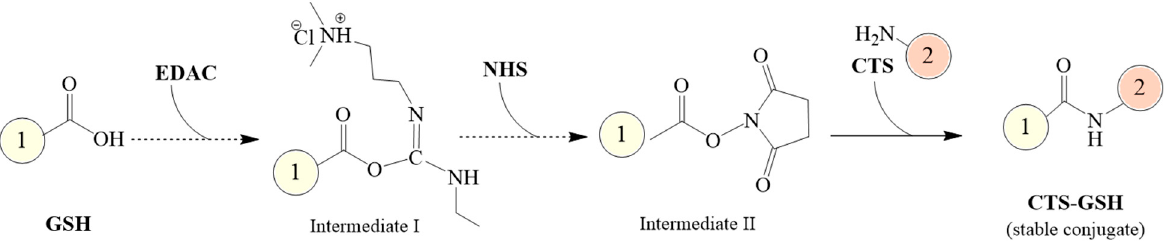
Figure 1. Synthetic route of CTS − GSH.